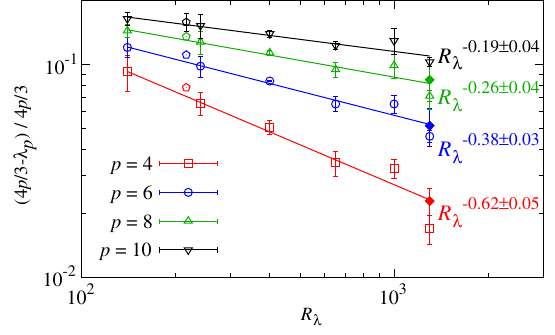
FIG. 12. The relative difference of the circulation scaling exponent λ p from the K41 exponent 4 p= 3 as a function of the Taylor-scale Reynolds numbers R λ , for orders p ¼ 4 , 6, 8, and 10. Data from Ref. [13] (pentagon) for orders p ¼ 4 , 6, 8, and 10, at R λ ¼ 216 , and the highly resolved DNS for orders p ¼ 4 , 6 and 8, at R λ ¼ 1300 ; 16384 3 (filled diamond), are provided for comparison. Exponential least-squares fits through the data are shown by the solid lines. Also shown are error